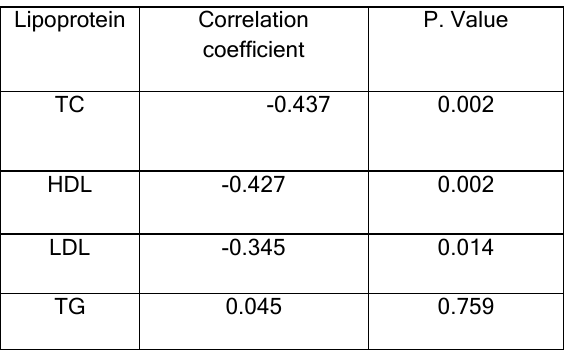
Table (3): Person correlation between blast percentage and different lipid profile variables